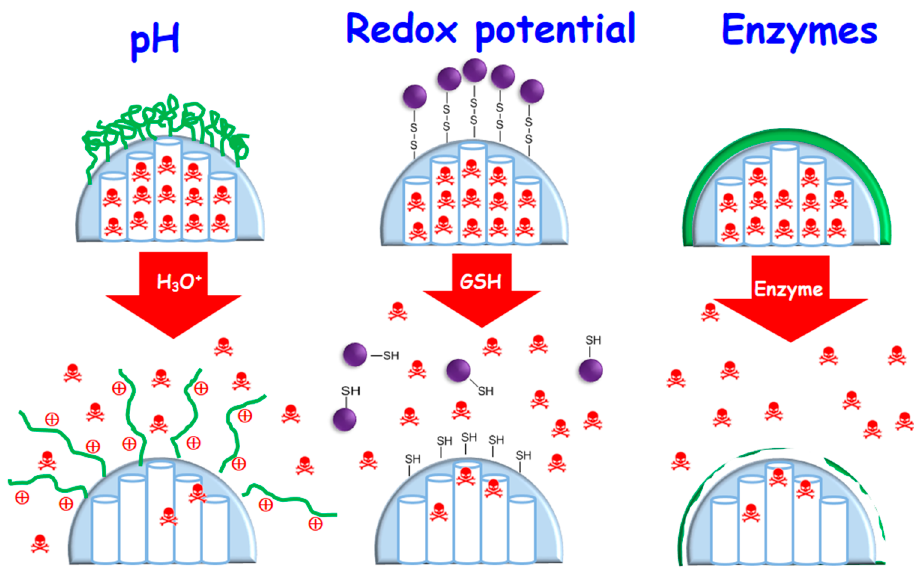
Figure 4. Schematic illustration of representative internal stimuli-responsive drug delivery MSNs: pH-responsive nanosystem based on polymer coated-MSNs; redox potential-responsive based on MSNs functionalized with disulfide bonds and capped with inorganic nanoparticles; and enzyme-responsive based on MSNs coated with a degradable polymer, from left to right. Table 2. Internal stimuli-responsive strategies for smart drug delivery MSNs.